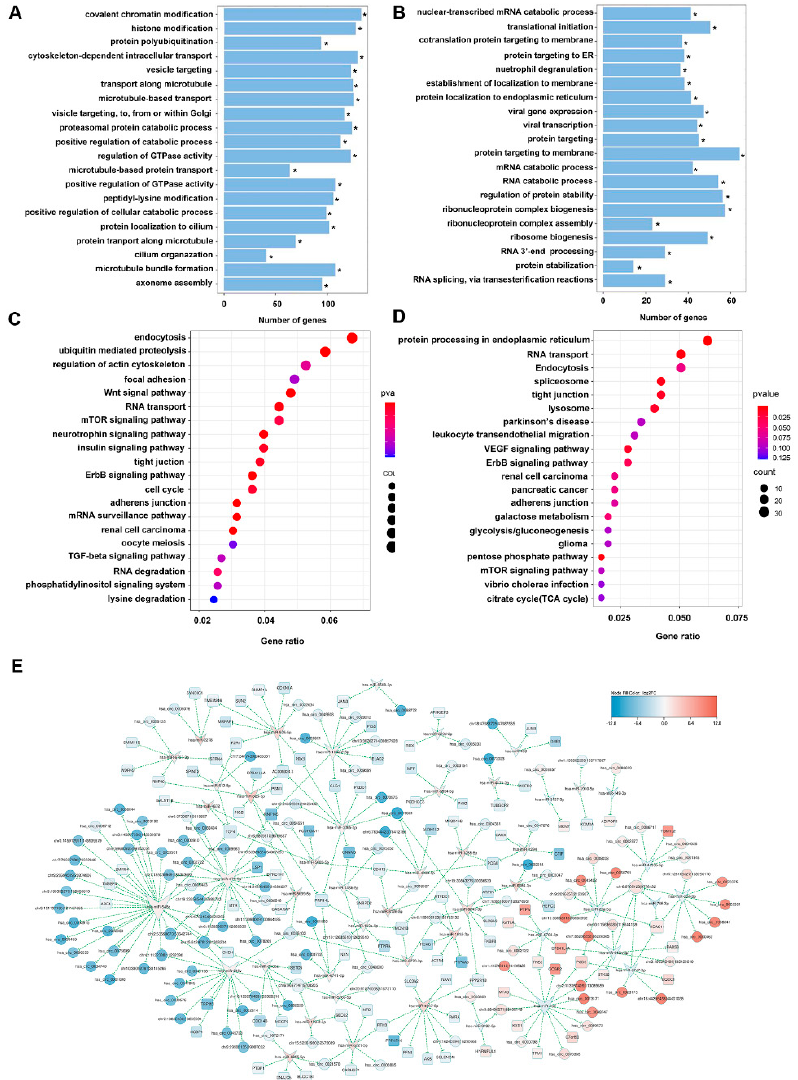
Figure 2. Functional enrichment analysis of DEcRs and DEGs and the predicted ceRNA network in HMC. ( A ) Enriched biological processes of GO by DEcRs. * p < 0.05. ( B ) Enriched biological processes of GO by DEGs. * p < 0.05. ( C ) Enriched KEGG pathways by DEcRs. ( D ) Enriched KEGG pathways by DEGs. ( E ) The ceRNA network. The association between miRNA, miRNA and mRNA was predicted based on correlation analysis according to the following standards: |log 2 FC| > 1 and p < 0.05, |PCC| > 0.8. Red node: upregulated circRNA, blue node: downregulated circRNA, blue arrows: downregulated miRNA, red arrows: upregulated miRNA, blue squares: downregulated mRNA, red squares: upregulated mRNA.